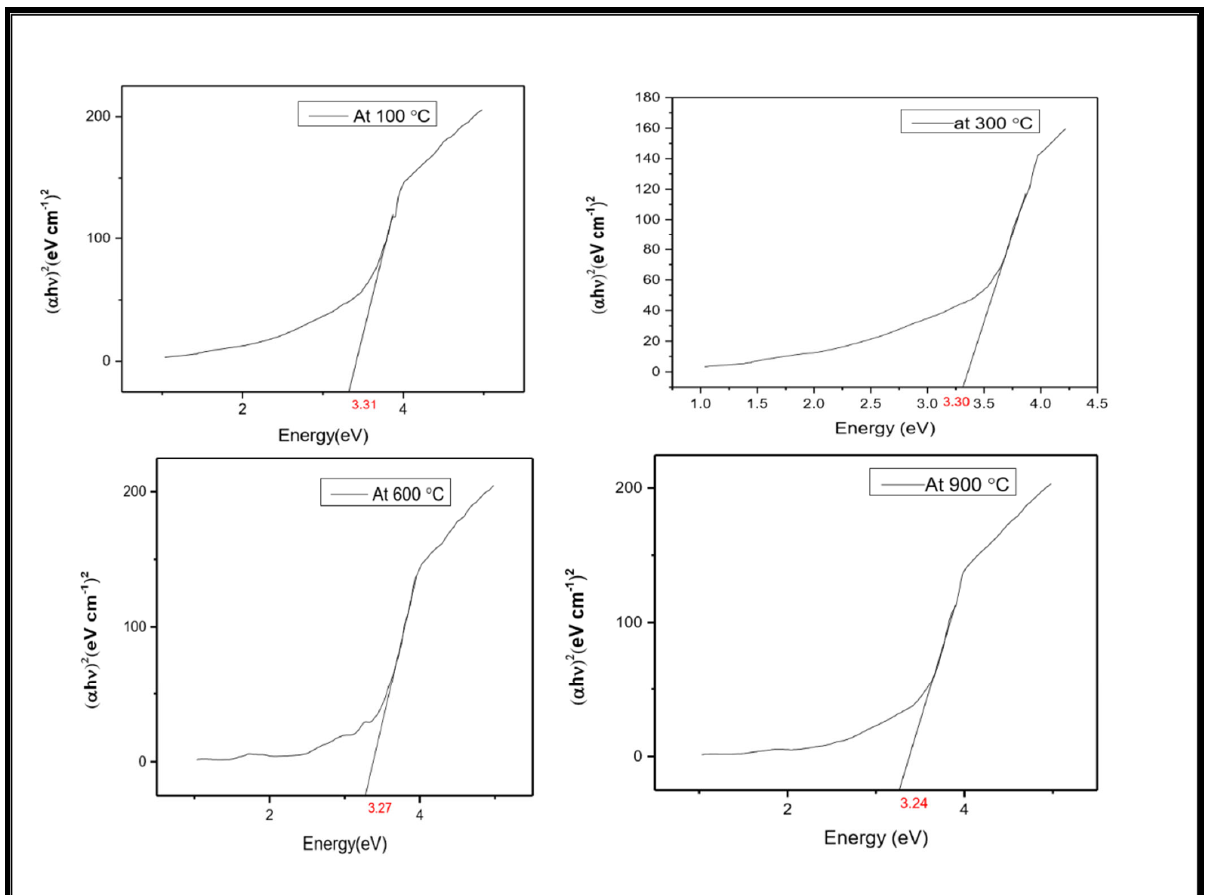
Figure 4. Determination by Tauc’s plot of the band gap of NiO-SnO 2 NCs calcined at the indicated temperature.